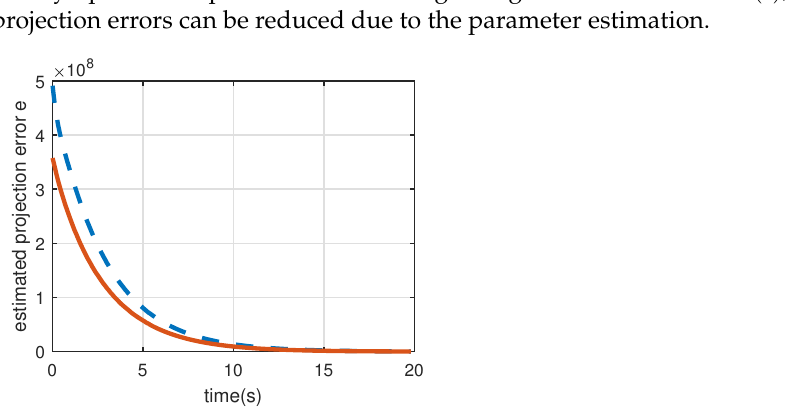
Figure 9. The evolution of estimated projection error.